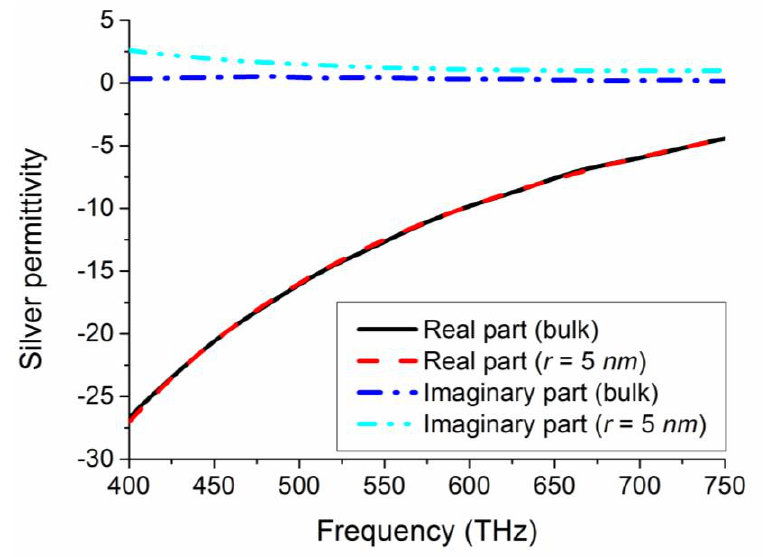
Figure 5. Comparison between the silver bulk permittivity and the one obtained with the size-corrected model Equations (7) and (8) for NPs with radius r = 5 nm